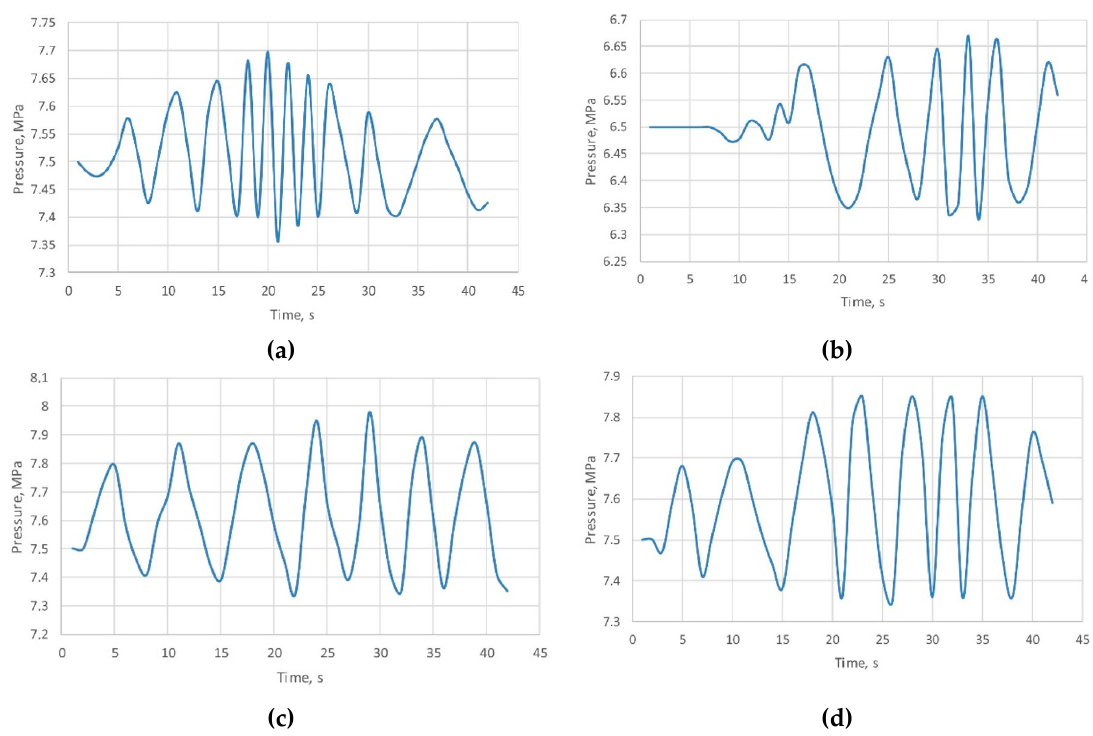
Figure 1. Results of unsteady process simulation with enabled en-route offtake of gas (pressure fluctuations at the beginning of the linear section): ( a ) at the initial pressure of 7.5 MPa; ( b ) at the initial pressure of 6.5 MPa; ( c ) at the initial pressure of 7.5 MPa, with offtake at the beginning of the section; ( d ) at the initial pressure of 7.5 MPa, with offtake in the middle of the section.